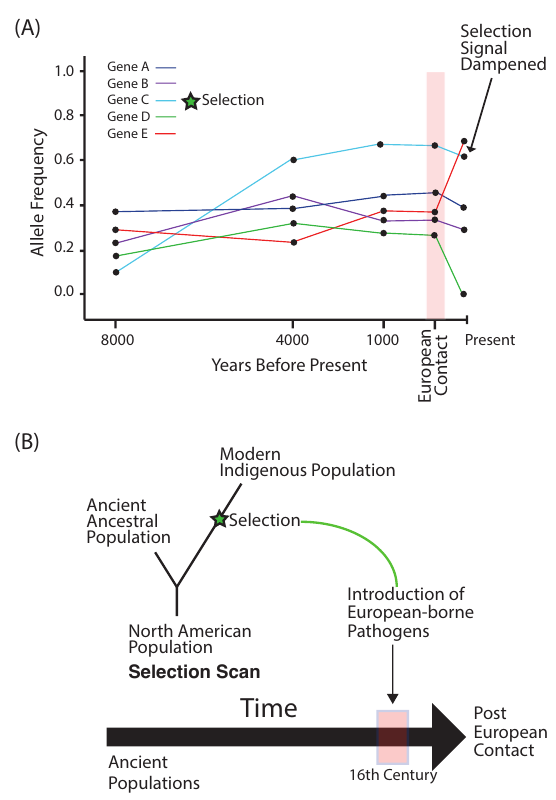
Figure 3. European contact and detecting selection. ( A ) The population collapse after Euro- pean contact may obscure ancient signals of selection by causing variants not under selection to rise to high frequency stochastically. ( B ) Design to detect positive selection in response to European-borne